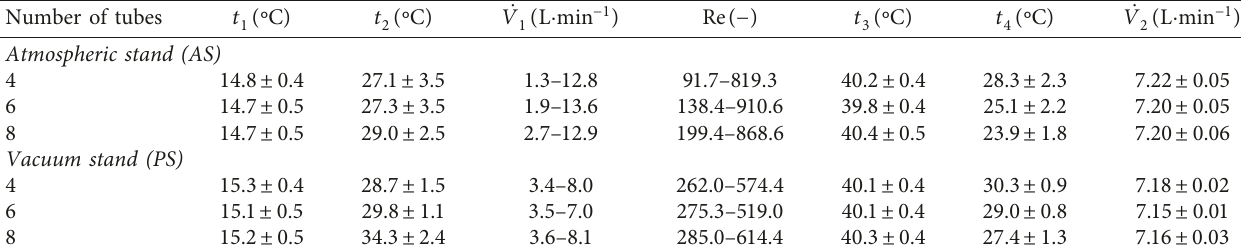
Table 1: Overview of basic measured and derived quantities. Number of